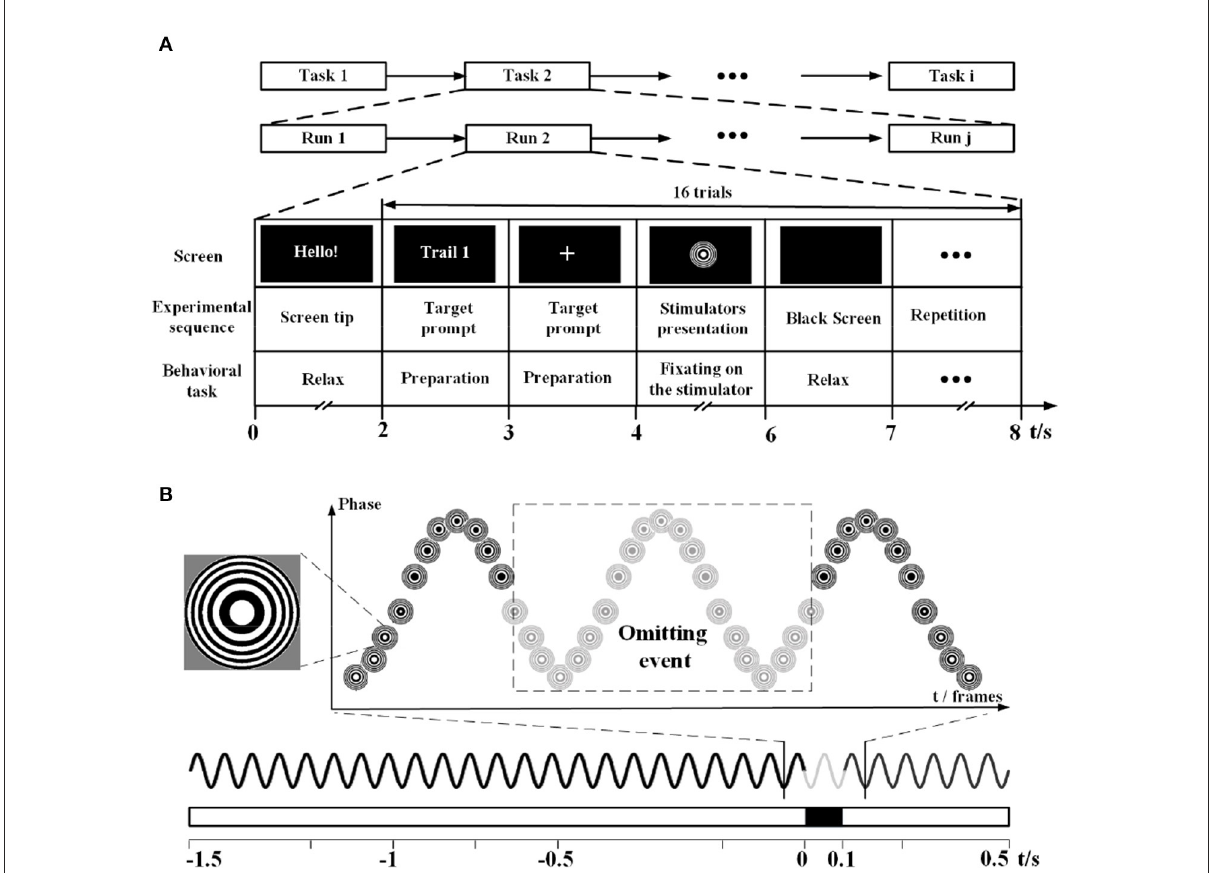
FIGURE1 The experimental sequence and the example of stimulus sequence. (A) The timing of the experimental sequence and behavioral task. For different experiments, the number of task runs, stimulators, or time duration may vary. (B) The bottom shows two simplified presentation methods of the stimulus sequence in a waveform graph or rectangular bar. The solid black line (or the white rectangular bar) represents the SSVEP stimuli, while the solid gray line (or the black rectangular bar) represents the omitting events. The top shows how this stimulus sequence is realized by arranging the frames of Newton’s ring